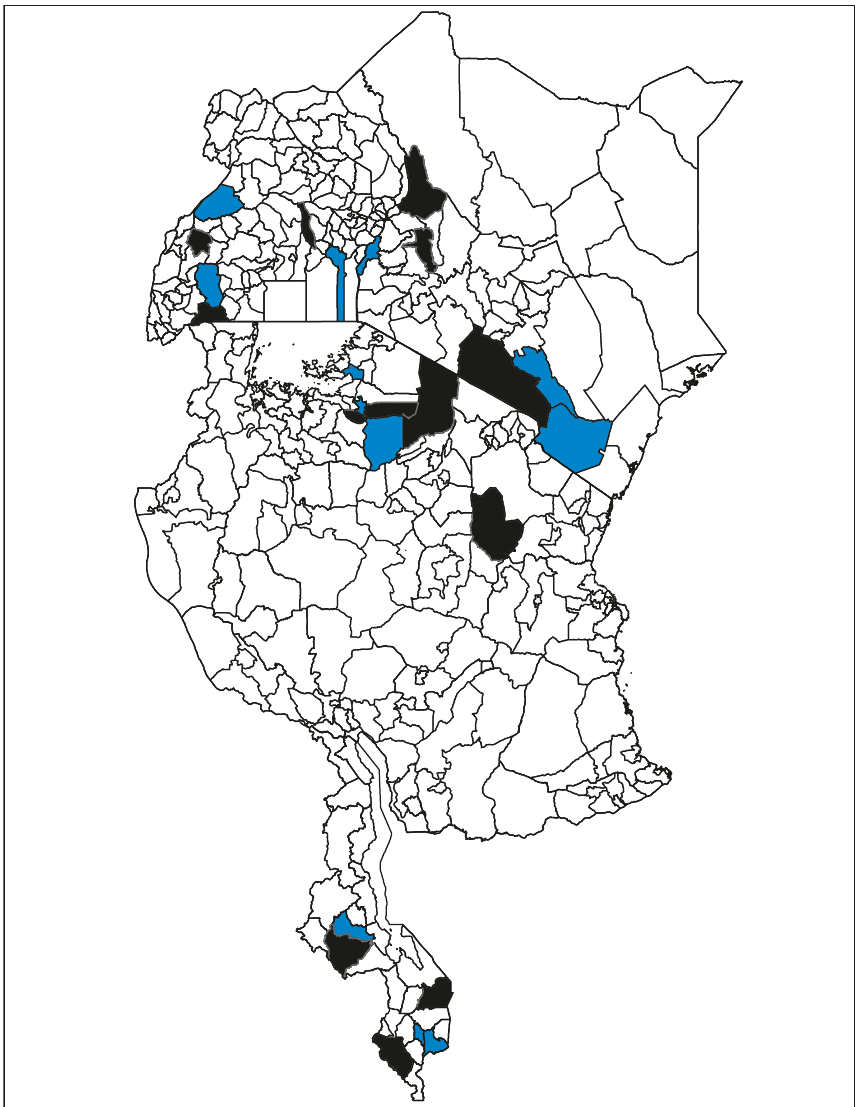
Figure 6: Top 3 districts within each country performing the best (in blue) and the worst (in black) with regard to the odds of anaemia in children (top left: Uganda; top right: Kenya; middle: Tanzania; bottom: